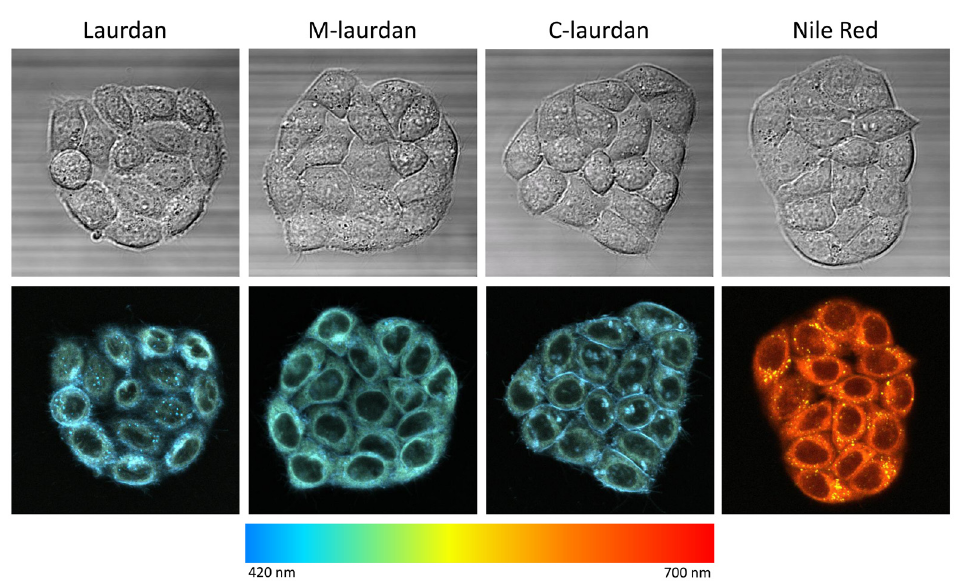
Figure 4. Colour-coded representation of lambda stacks reveals different colours for different cellular compartments, suggesting that it may be possible to perform spectral deconvolution. Colour coding was achieved using the built-in ‘time-lapse colour coding’ pluggin of ImageJ, after converting the 29 channels stacks into 29 frames stacks. In designing this lut (called rainbeau), we attempted roughly to match the wavelengths of the corresponding